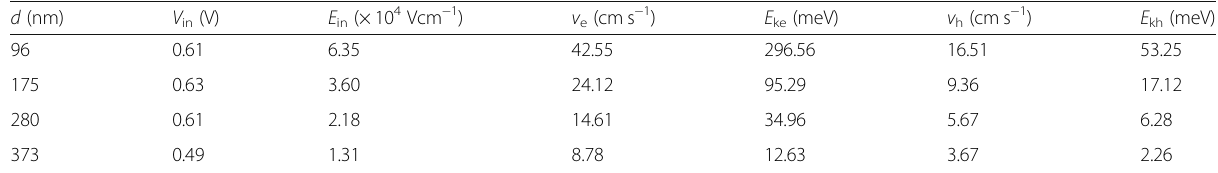
Table 2 Parameters of V in , internal electric field E in , drift velocity of the electron ( v e ) and hole ( v h ), and kinetic energy of the electron ( E ke ) and hole ( E kh ) in the dark of the solar cells with different CBD t